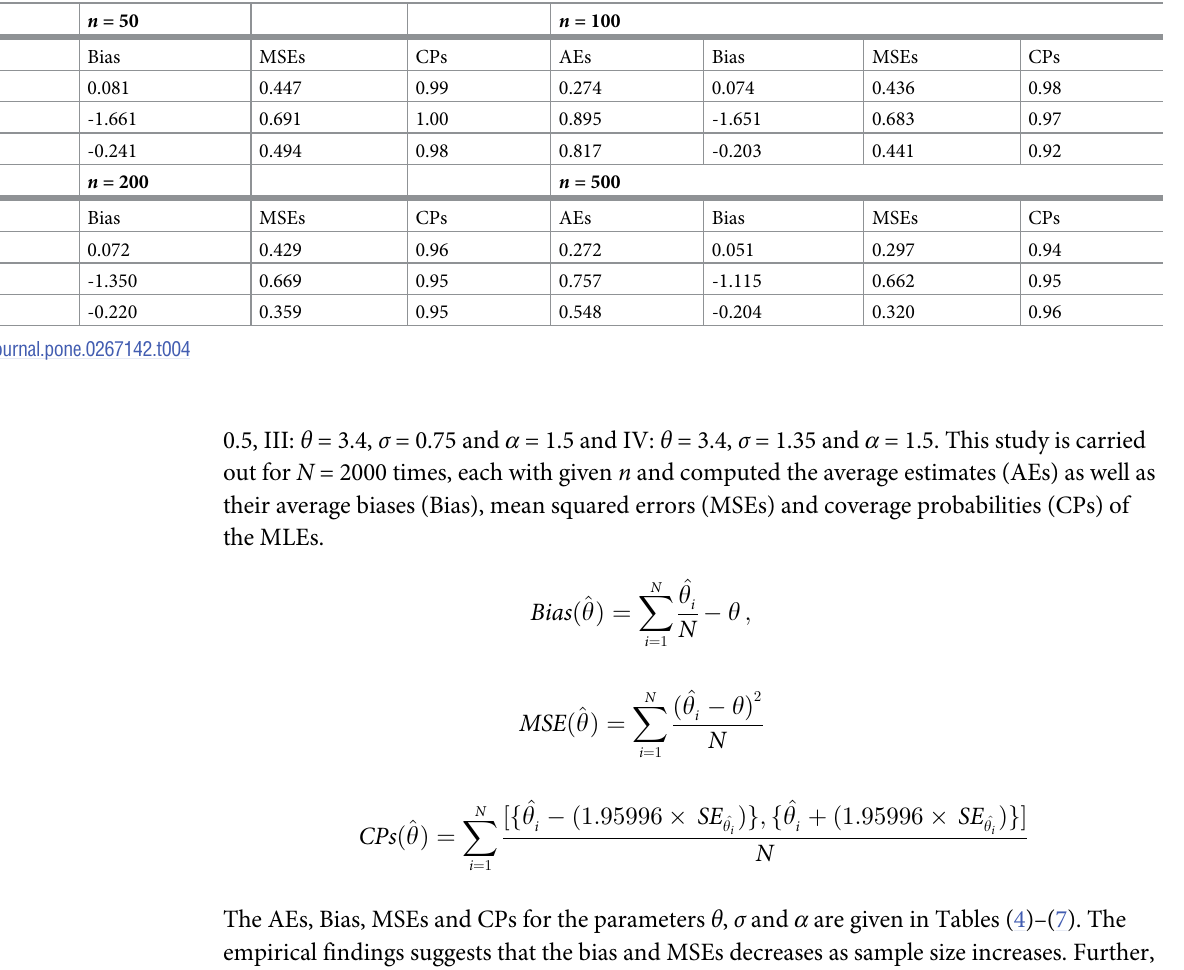
Table 4. AEs, Biases, MSEs and CPs for combination-I.